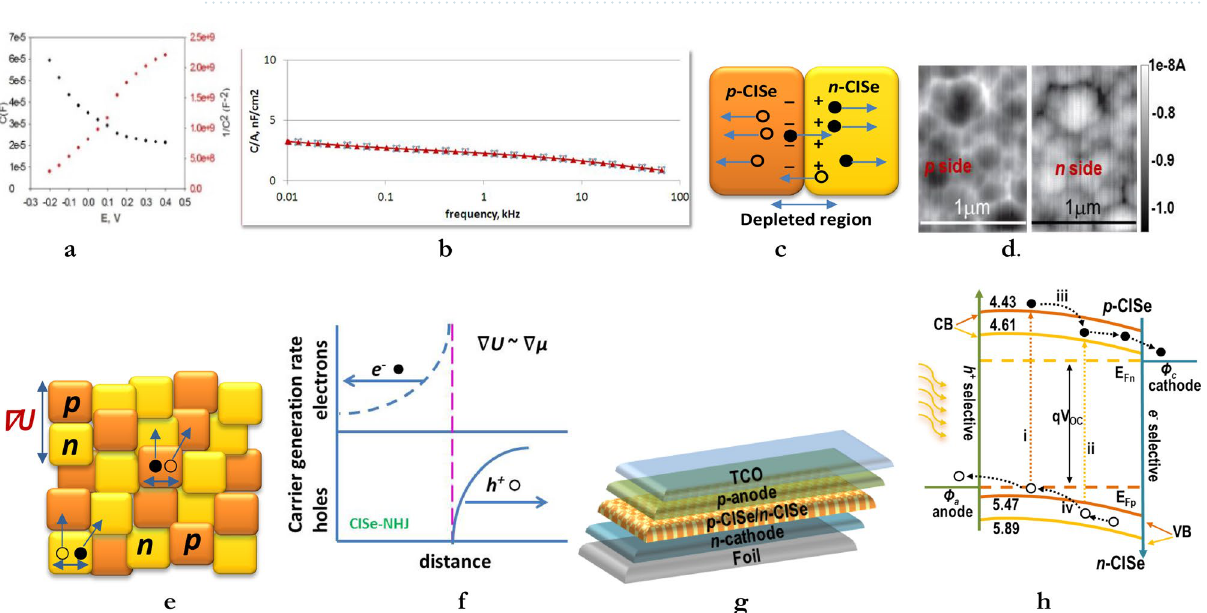
Figure 5. ( a ) Mott–Schottky plots of V versus C and 1/ C 2 and ( b ) admittance spectroscopy at 300°K for CISe/ SO 3 2 junction with film S5; ( c ) Schematic of depleted p- CISe/ n -CISe junction; ( d ) EBIC mapping on either side of SS/CISe(S6)/ITO device at 10 V; ( e ) Schematic of electron–hole pair generation and separation in pn NHJ; ( f ) Potential gradients ∇ U ≈ ∇ µ that drive device operation; ( g ) typical device structure; ( h ) band-to-band and intraband transitions in CISe